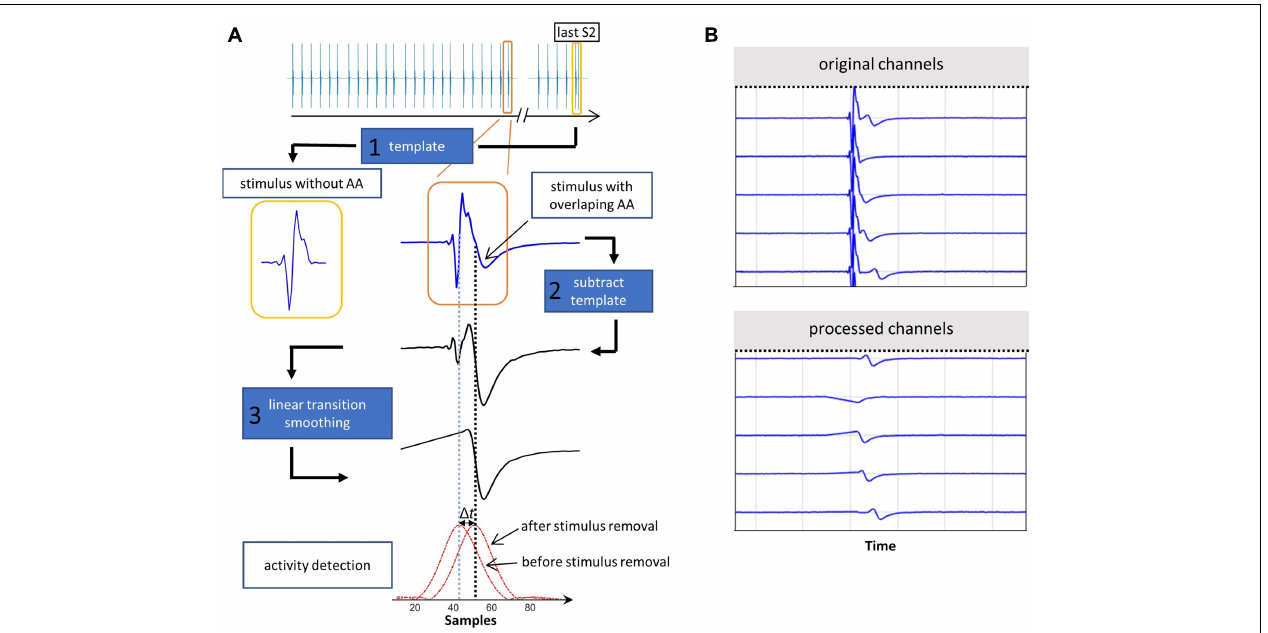
FIGURE 3 | (A) Elimination of stimulation artifact. Exemplary stimulation signal covering an atrial activity from an S1S2 pacing protocol (orange). Template (1, yellow) chosen from the last part of the S1S2 protocol. After template subtraction (2) and linear signal smoothing (3), the maximum of the NLEO activity detection signal (red), shifts by (cid:49) t from the stimulation (vertical blue dotted line) to the now uncovered atrial activity (black dotted line). (B) A synthetic signal segment containing stimulations followed by atrial activities. In some cases, the atrial activity is covered by the stimulation (original channels). After the matched filtering method is applied, all atrial activities become visible (processed